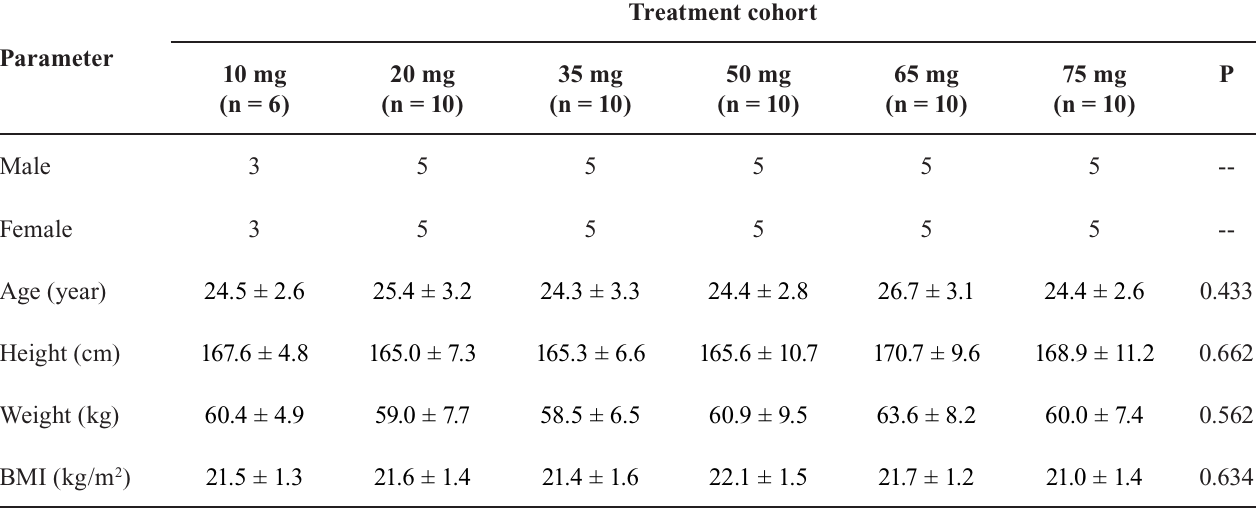
TABLE I - D emographic and baseline characteristics of enrolled subjects of all cohorts